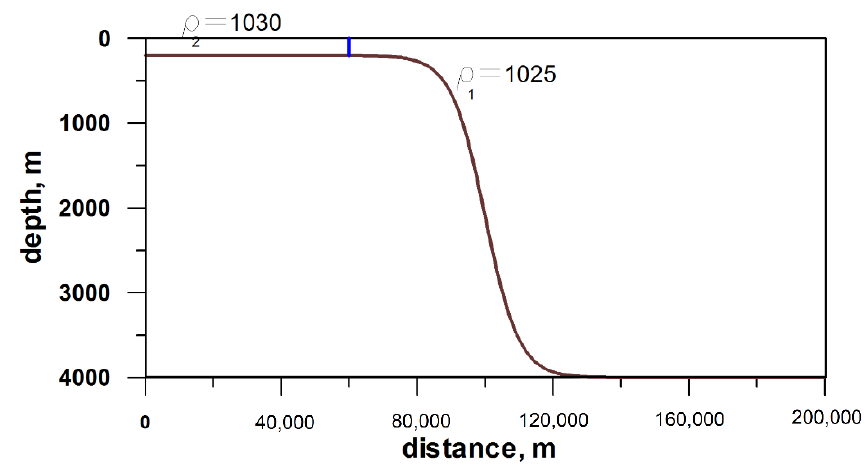
Figure A1. The initial setup for lock-exchange on shelf break.